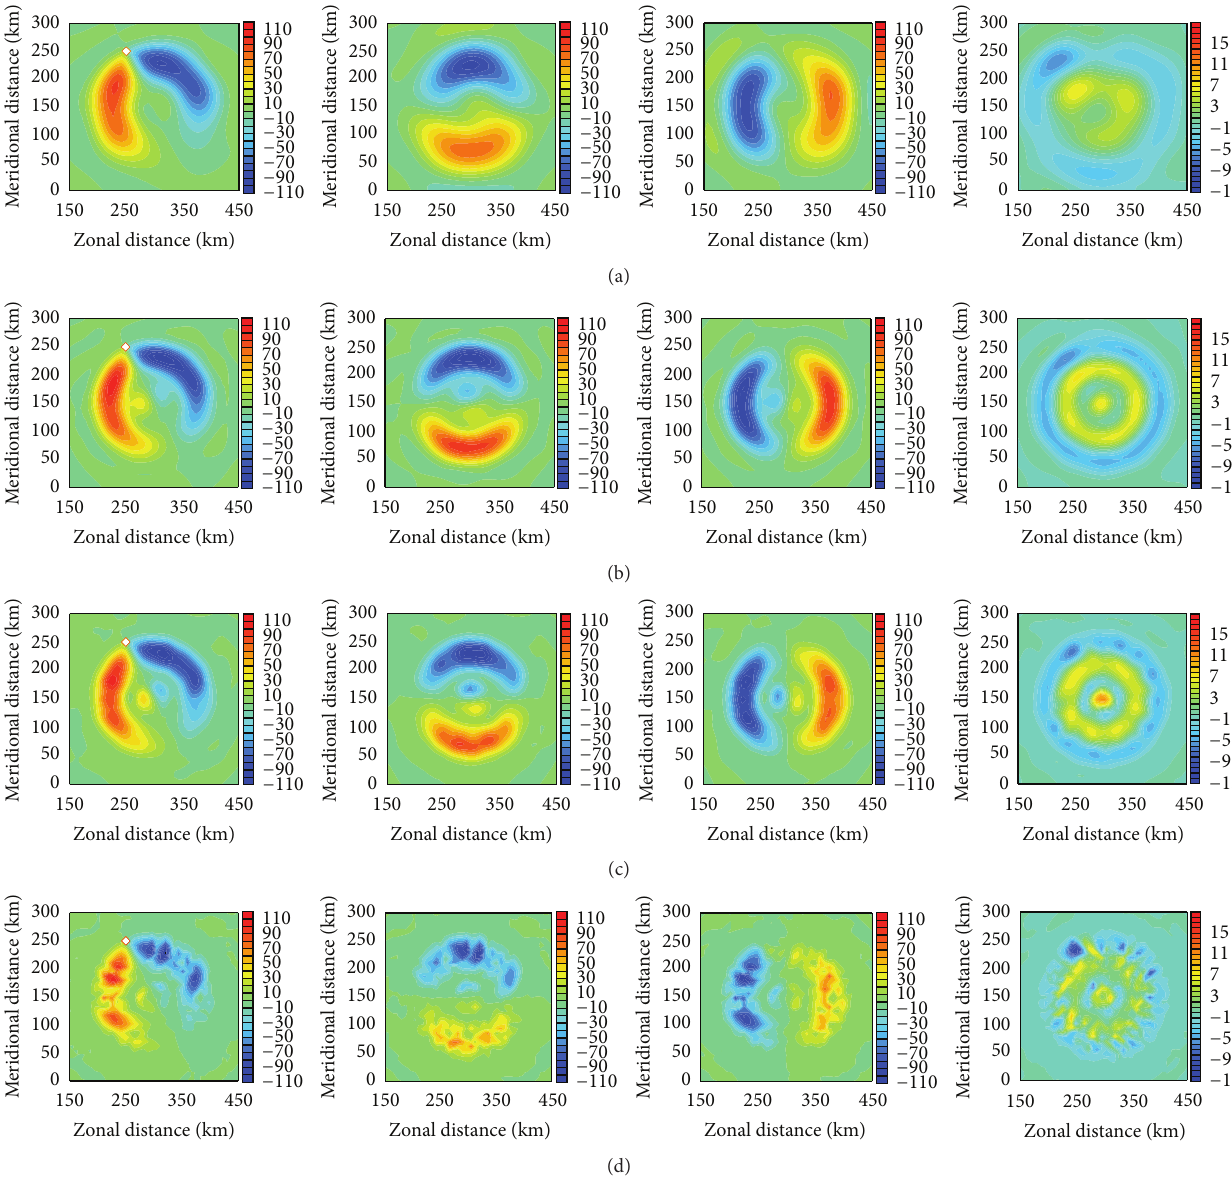
= 25 km, 𝐿 = 25 km, and 𝐿 𝑥 𝑦 = 0.625 km (d) (unit: 𝑧